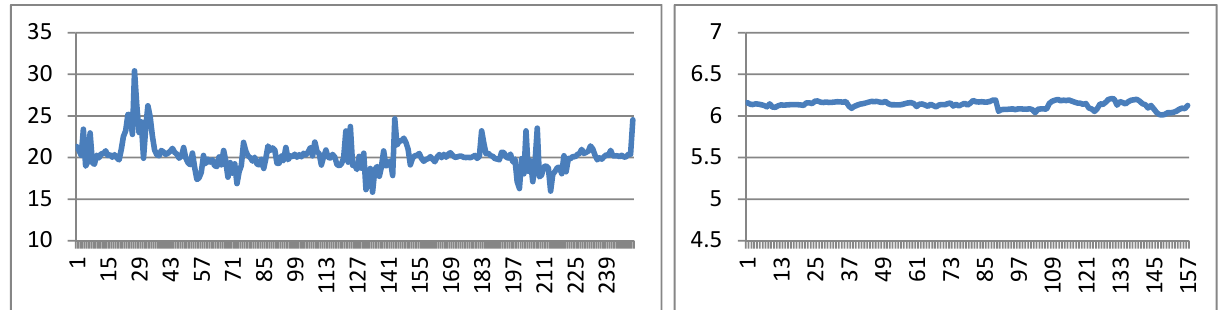
Figure 6. Focal lengths of Lumix GF1 ( left ) and Ricoh GR3 ( right ) for each image calculated by Photosynth (in